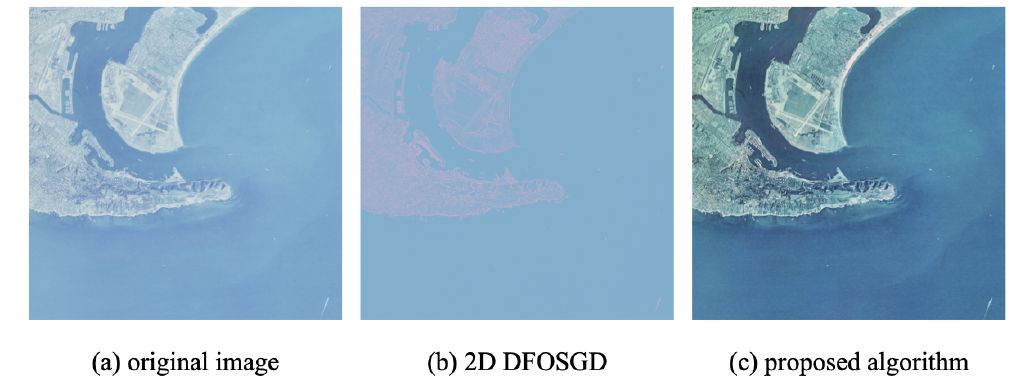
Figure 14. Enhancement results of image “2.2.02”.